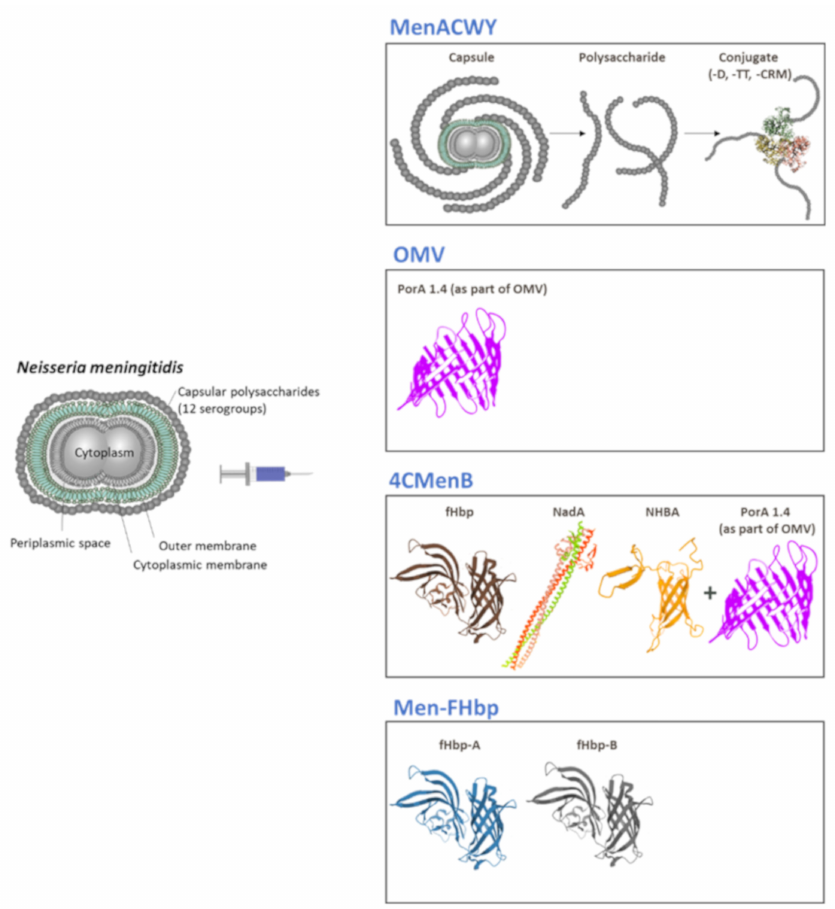
Figure 3. Structure of the meningococcus and overview of the di ff erent antigens used in meningococcal conjugate and protein-based vaccines. Abbreviations: D, diphtheria toxoid; TT, tetanus toxoid; CRM, diphtheria protein cross-reactive material 197; PorA 1.4, Porin A protein; OMV, outer membrane vesicles from New Zealand strain NZ98 / 254 containing PorA 1.4; fHbp, factor H binding protein; NadA, Neisseria adhesin A; NHBA, Neisserial heparin binding antigen; fHbp-A and -B, variants of fHbp from 2 subfamilies. Antigen images from the RCSB PDB (rcsb.org) of PDB ID 3KVD [44], 6EUN [45] and 2LFU [46], Mol* [47]. The PorA image reproduced with permission from Derrick et al.